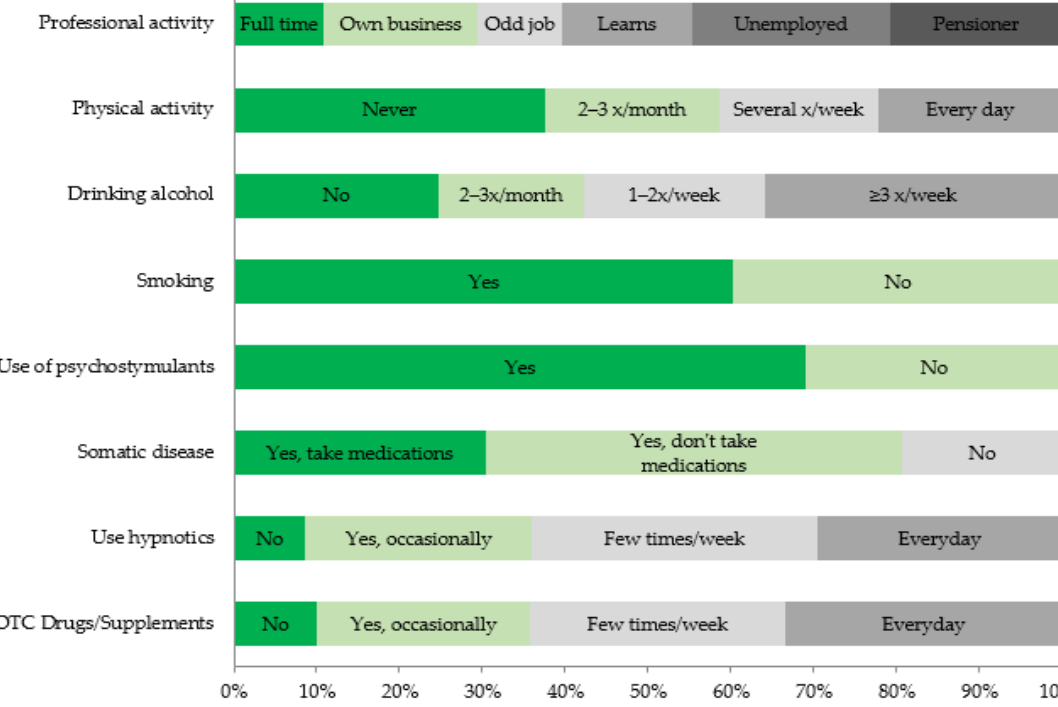
Figure 3. Factors modifying the risk of anxiety disorders (HADS-A3) that were statistically significant. The prevalence of anxiety disorders in women and men was similar. Women met the criteria for depressive disorders significantly more often than men. In the group of re- spondents over 60 years of age, depressive disorders occurred much more often and were found in 34.9% of people compared to those in the age group 18 – 39 years old (5.7%) and